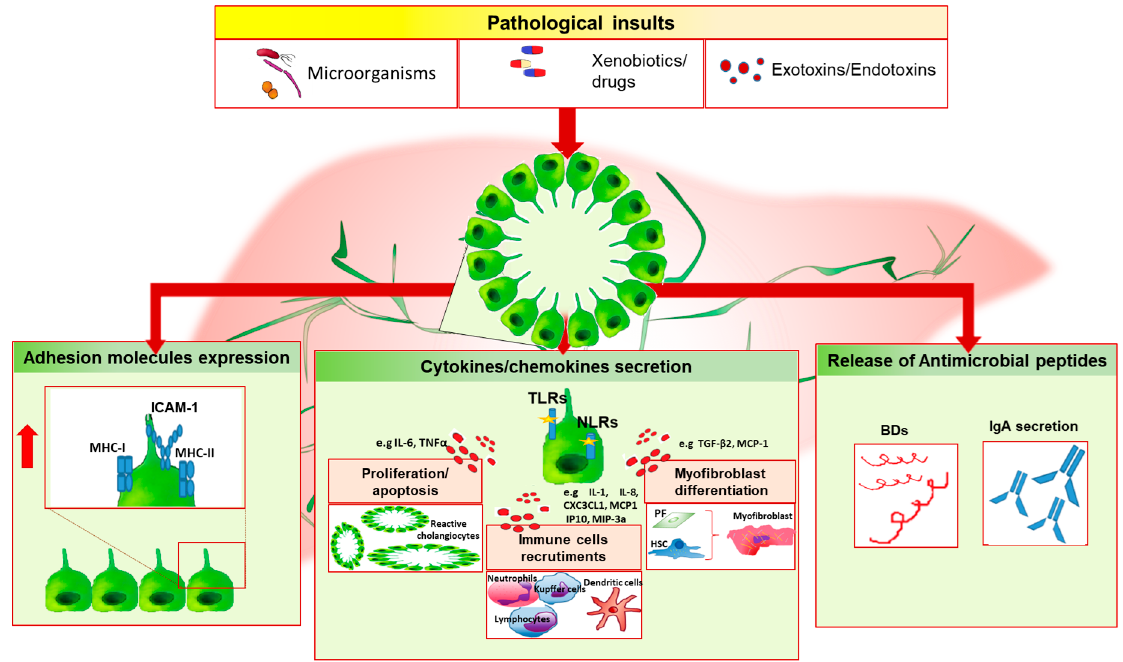
Figure 1. Cholangiocyte immune response. Biliary epithelial cells are exposed to different dangerous stimuli such as microorganisms, drugs or toxins, and others exotoxins/endotoxins which trigger tissue damage. In this setting, cholangiocytes may modify their biology and phenotype by increasing the release of proinflammatory mediators (e.g., IL-6, IL-8, IL-1), which act in autocrine/paracrine fashion on both resident and non-resident cells, by upregulating the expression of surface proteins (i.e., MHC-I, MHC-II and ICAM-1) and by releasing antimicrobial molecules such as beta-defensins (BDs) or IgA following epithelial transcytosis. These events lead to ductules’ proliferation, immune cells chemotaxis and myofibroblast differentiation. In case of persistent biliary damage, these processes could lead to chronic inflammation and fibrosis establishment. PF, portal fibroblast; HSC, hepatic stellate cell.